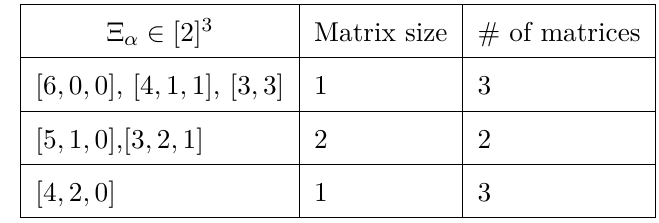
Table 4 . The multiplicity table for Ξ α